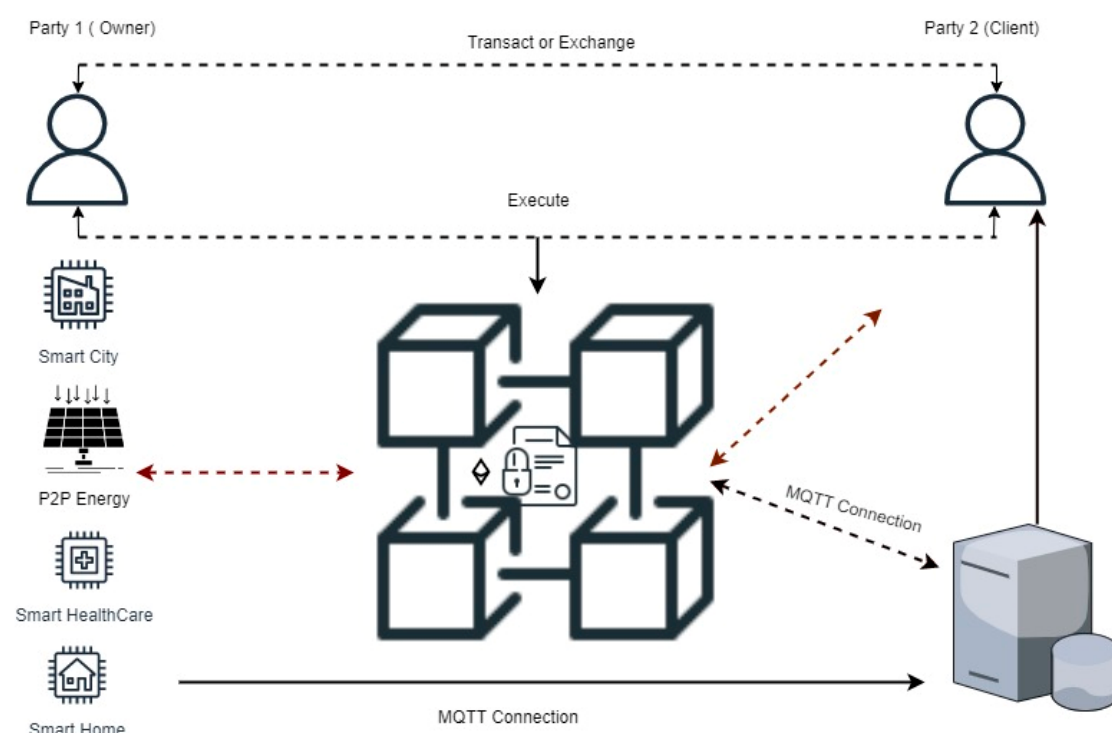
Figure 4. IoT topology overview of using smart contract.